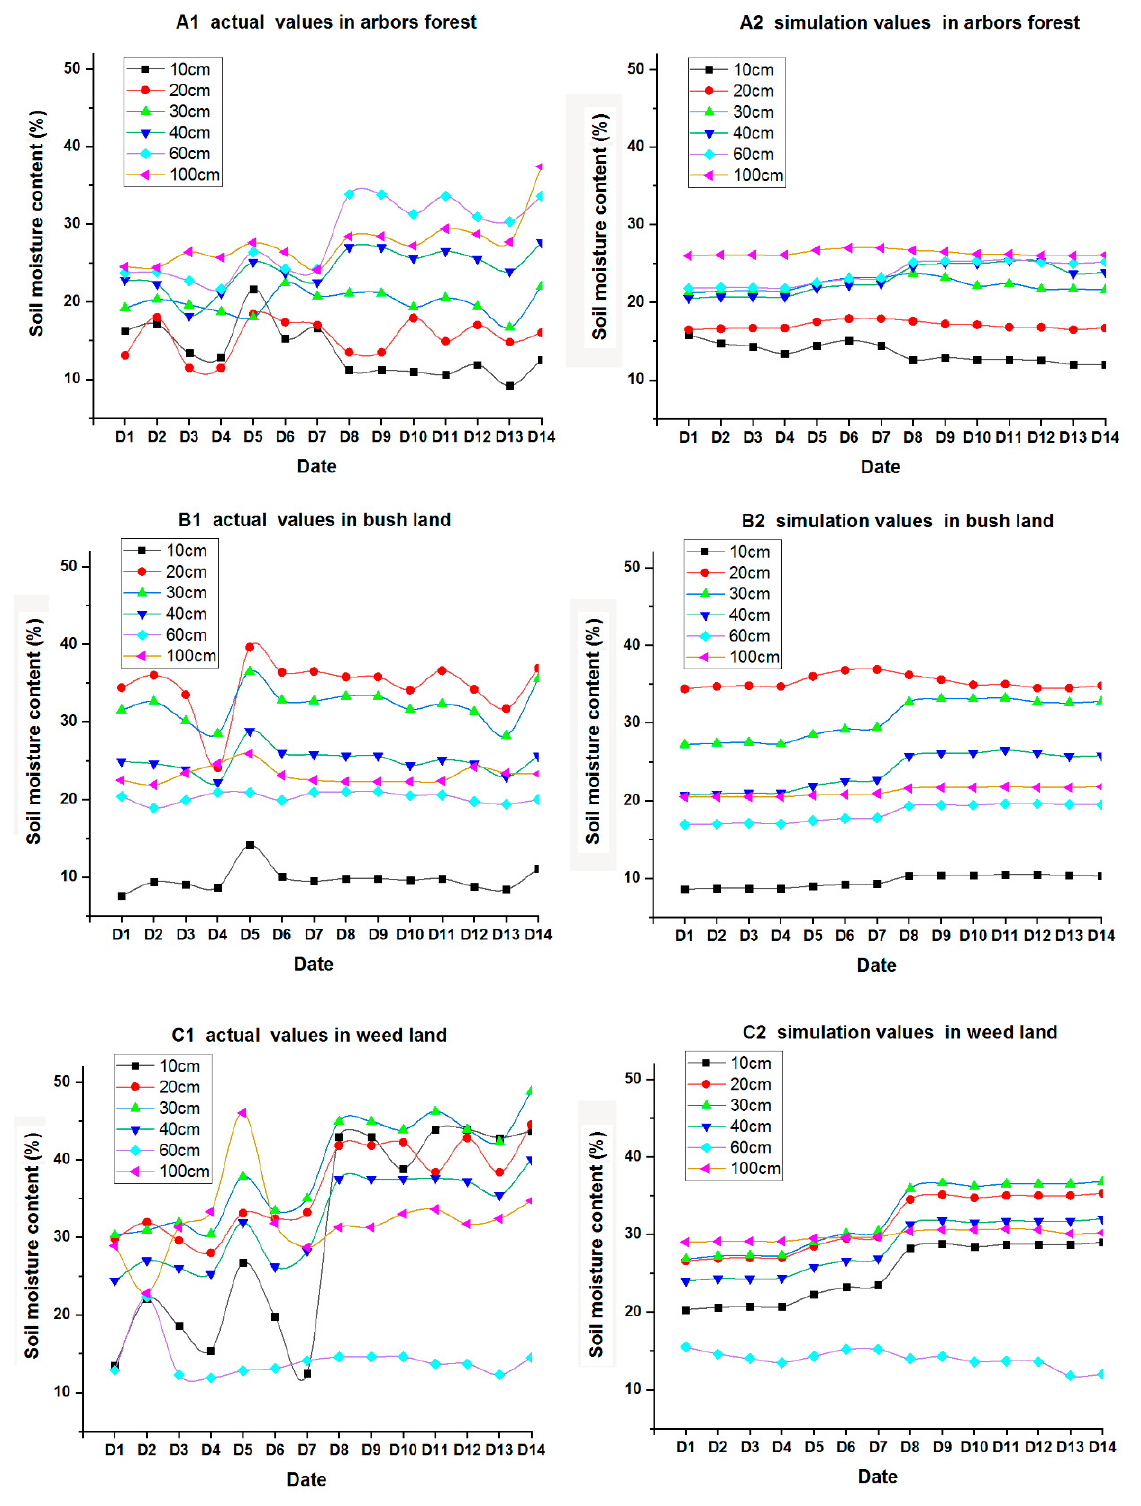
Figure 12. The comparison of actual values and simulation values at different soil depths for